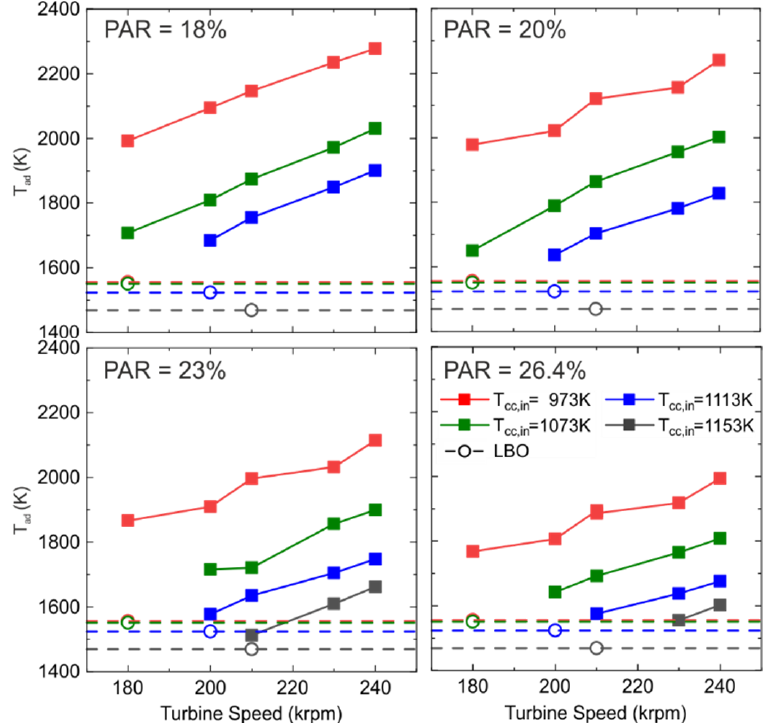
Figure 7. Adiabatic flame temperature T ad of investigated stationary load points and at lean blow-off limits.